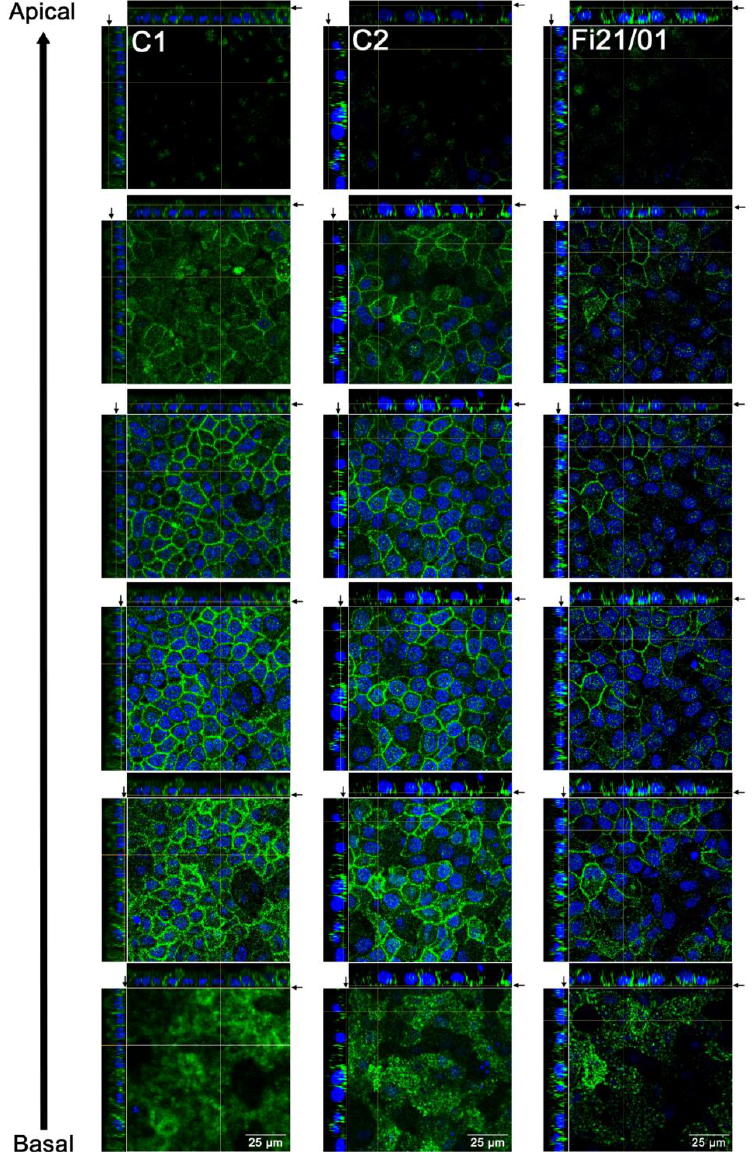
Figure 3. Bestrophin expression from basal to apical regions of iPSC-RPE cells. BEST1 localization determined by immunofluorescence on both controls and Fi21/01 iPSC-RPE and showing of the orthogonal view of the z-stack from different z-stacks from the apical to the basal zone. Arrows in the orthogonal views show the cutting point for horizontal images. Scale bar: 25 µm.